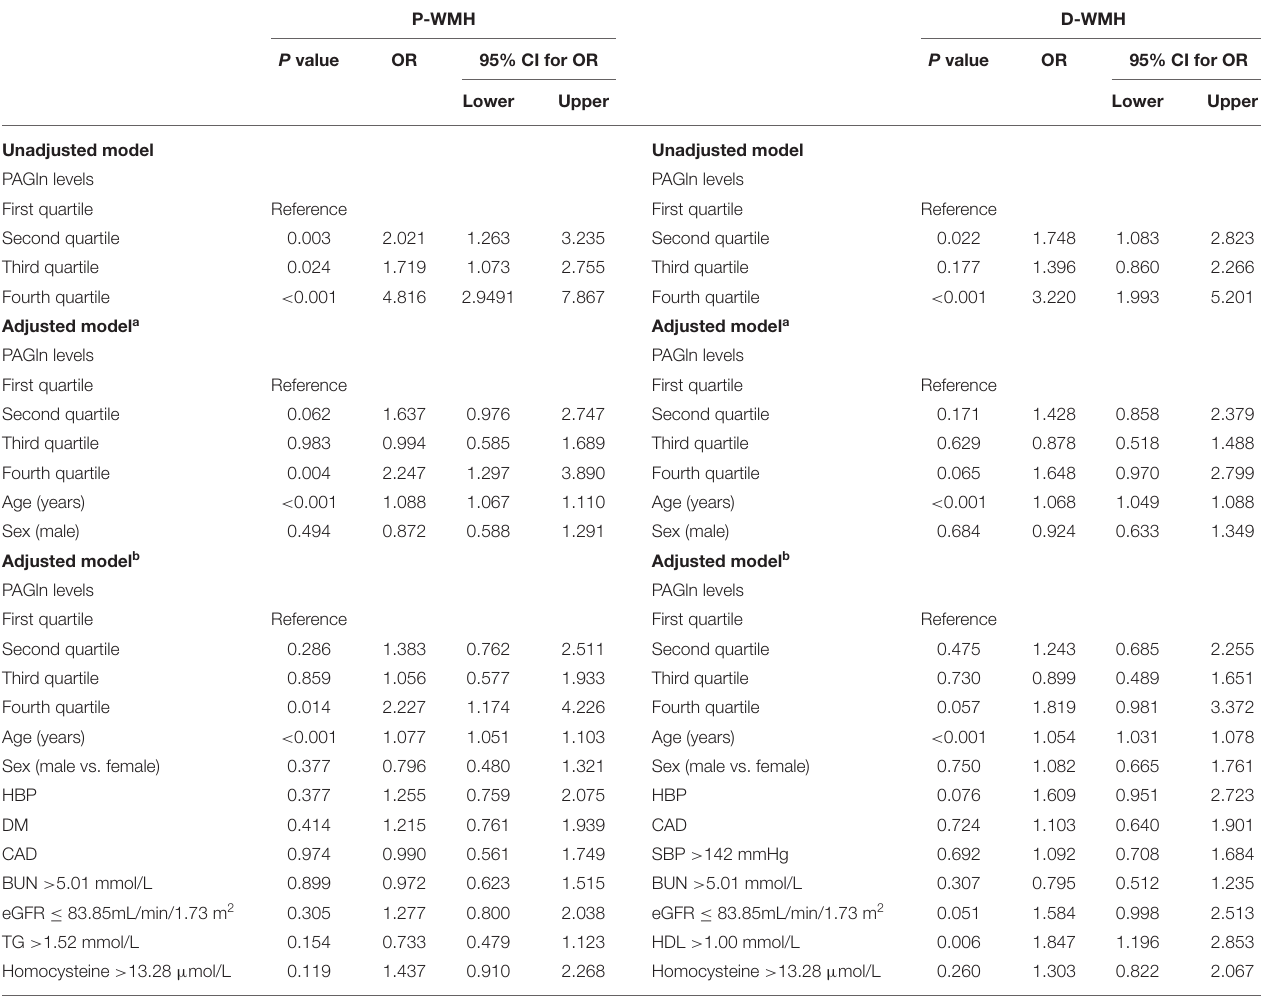
TABLE 5 | Logistic regression analyses of the association between PAGln levels and P-WMH and D-WMH. P-WMH D-WMH P value OR 95% CI for OR P value OR 95% CI for OR Lower Upper Lower